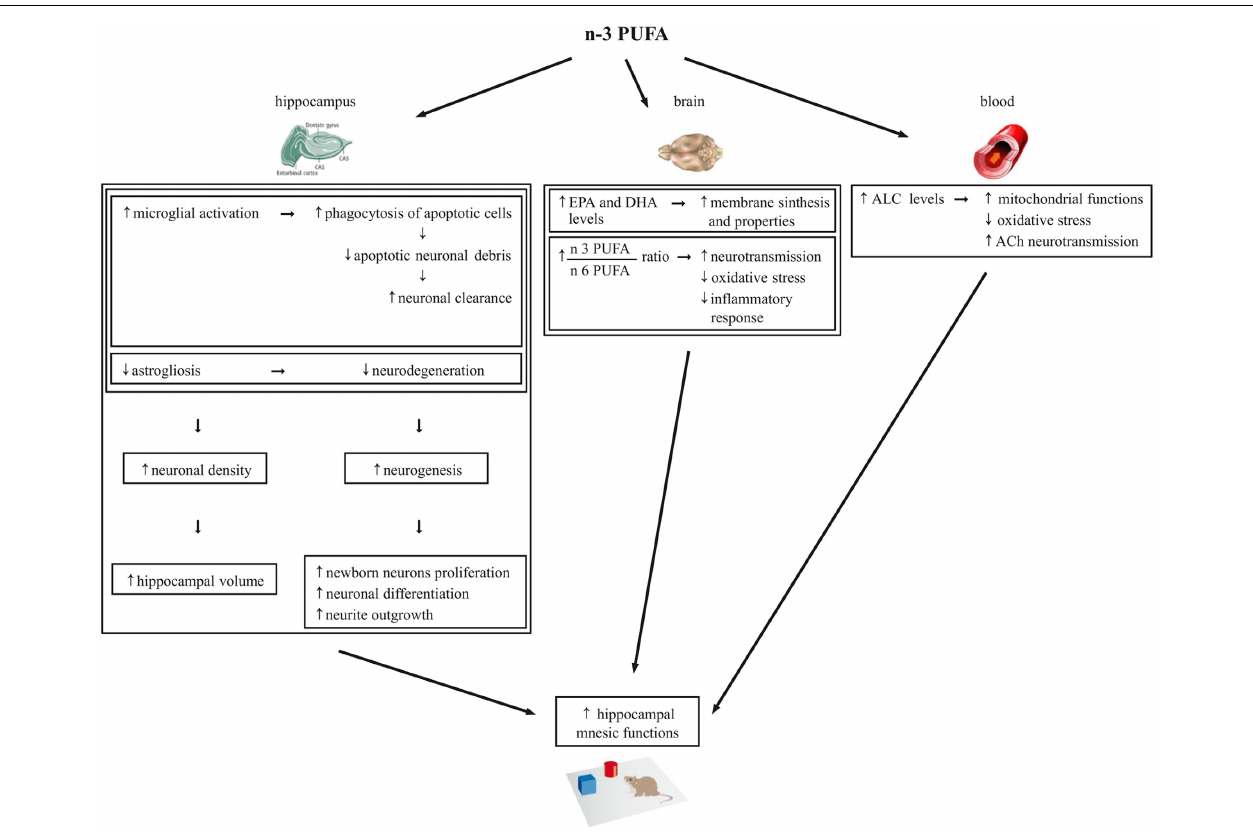
FIGURE 7 | Schematic representation of the cellular mechanisms underlying the beneficial effects of n-3 PUFA supplementation on hippocampal-dependent mnesic functions in aged mice.